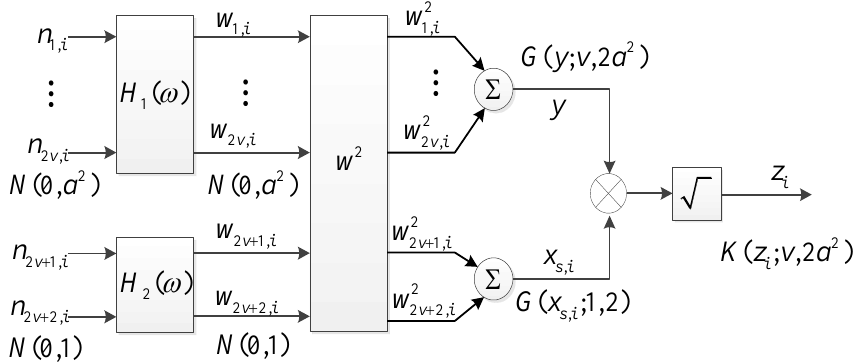
Figure 1. Flow diagram of zero memory non-linear (ZMNL) for generating correlated compound Gaussian-distributed clutter.